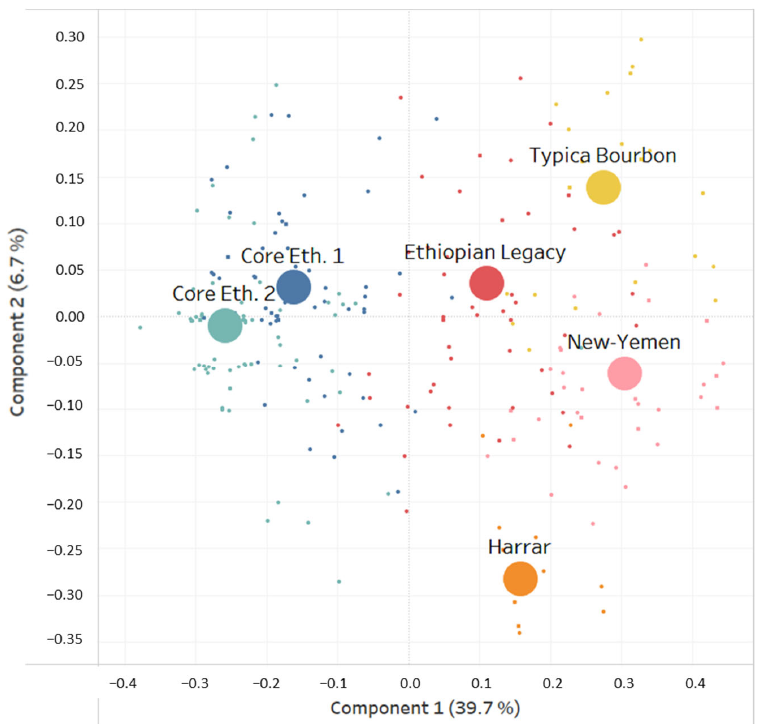
Figure 6. Representation of the first two components of the PCoA performed on Dice index dissimilarity matrix produced from 10 SSR markers on 555 C. arabica samples. Small circles are individual samples and large circles are the barycenter of each genetic cluster.